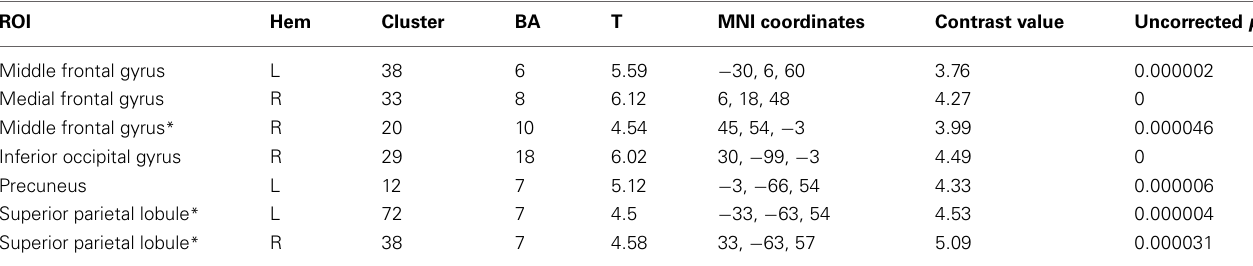
Table 4 | Functional ROI analysis for within-group comparison of the Color group contrasting 2-relational vs. 1-relational conditions. ROI